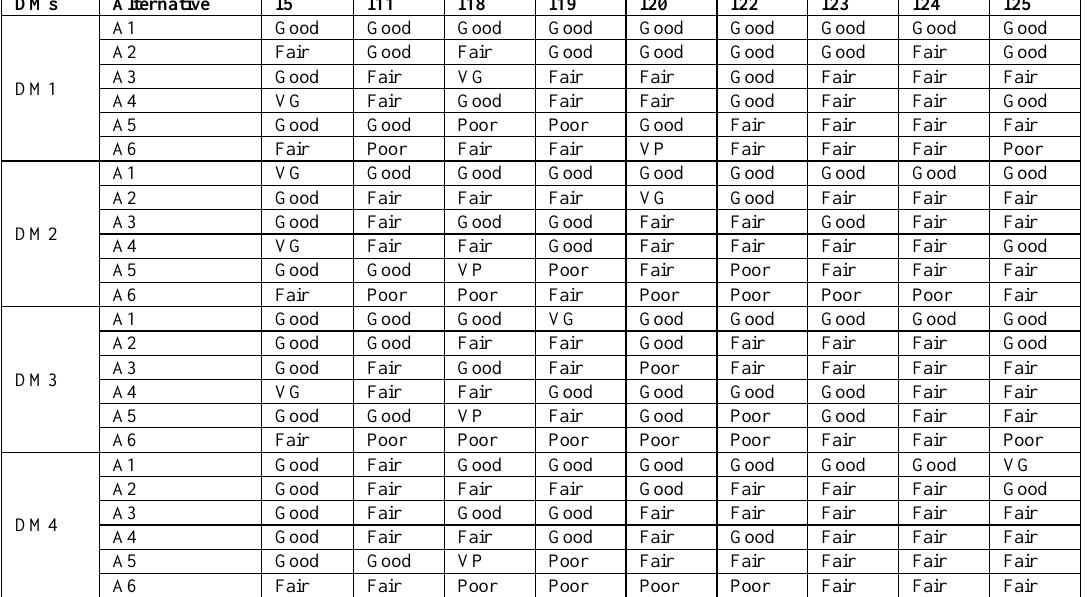
Table 4. Individual assessments in accordance to the subjective indicators